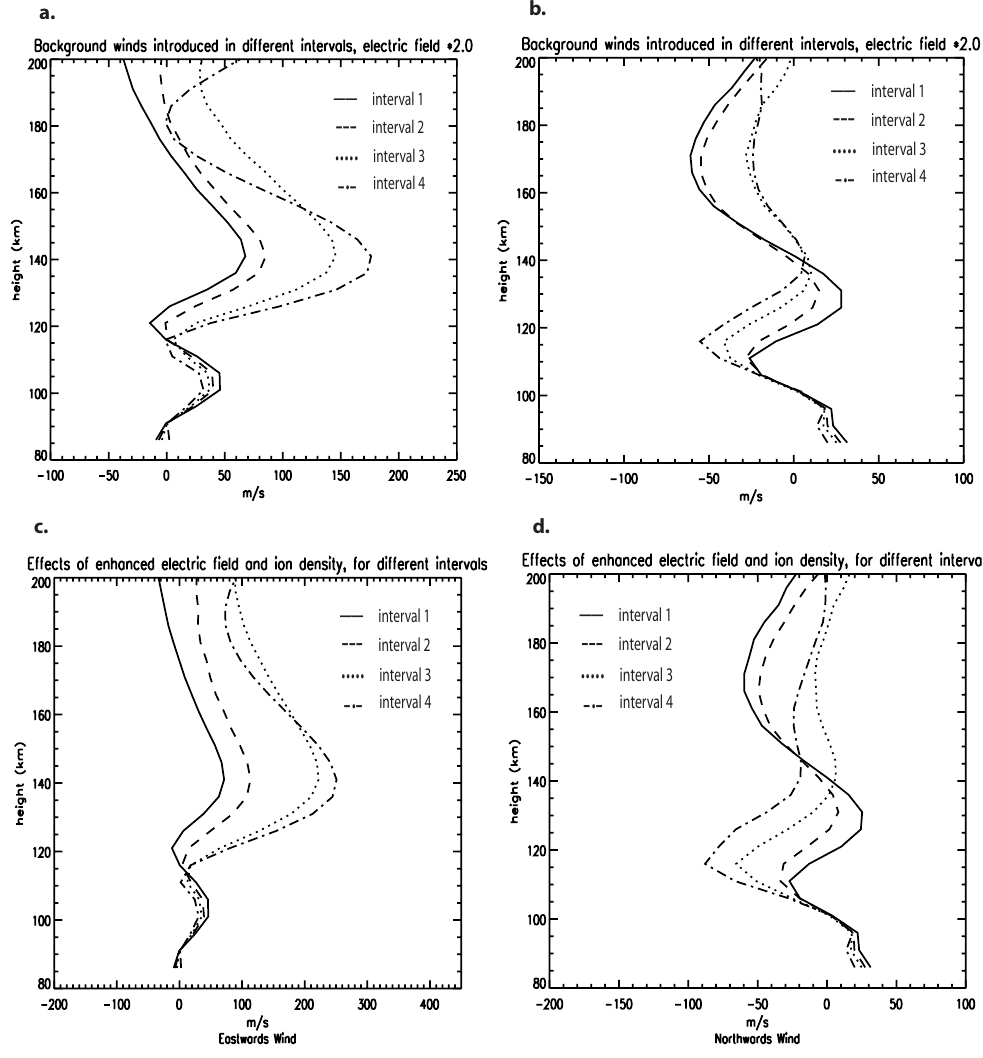
Fig. 7. (a) , (b) Effects of multiplying the electric field magnitude by 2.0 for background winds introduced at the beginning of different intervals. (c) , (d) Effects of multiplying both the electric field and ion density enhancement by 2.0, for background winds introduced at the beginning of different